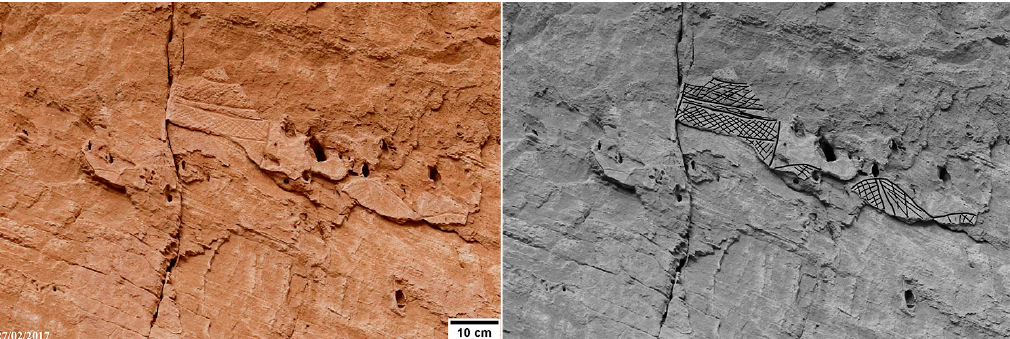
Figure 18. A fragment of an oval engraving (E5) with a longitudinal element tapering in a rounded termination (black and white version: interpretation by tracing, Photo: Alessandro Menardi Noguera).